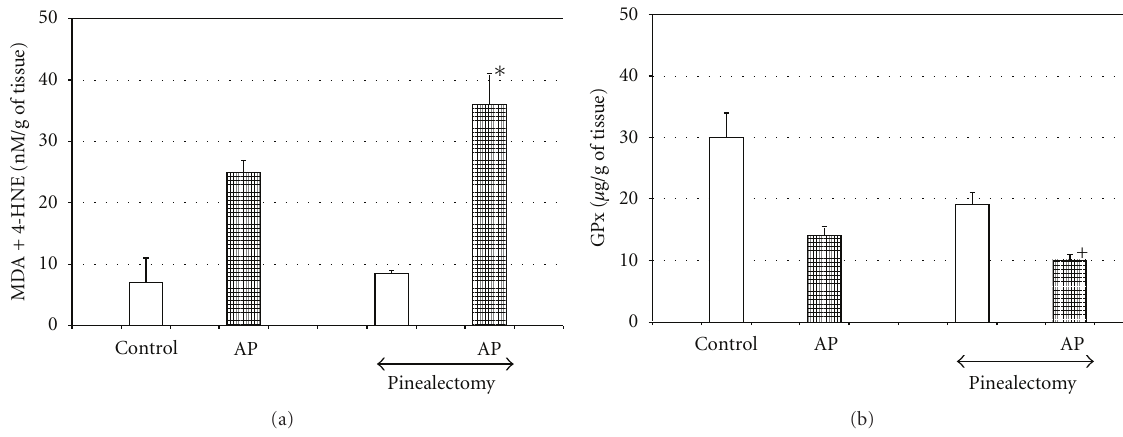
Figure 4: E ff ect of pinealectomy on pancreatic contents of glutathione peroxidase (GPx) and lipid peroxidation products (MDA + 4-HNE) in the pancreatic tissue of rats with acute pancreatitis. Control—intact rats. Means ± SEM from the separate experiments, each performed on 8–10 rats. Asterisk indicates significant increase above the value detected in AP with intact pineal gland. Cross indicates significant decrease below the value detected in AP with intact pineal